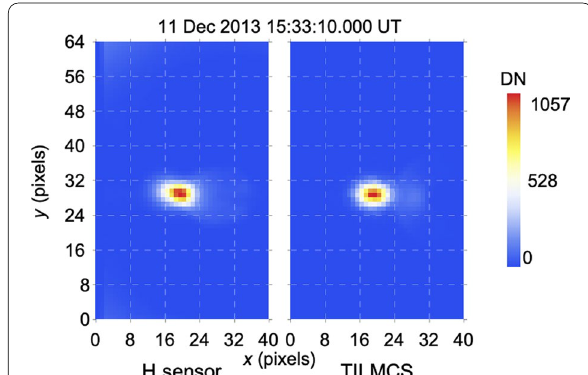
Fig. 5 Swarm C H sensor image (left) and TII MCS model (right): 11 December 2013 at 15:33:10 UT. Model parameters: 85% O + , 15% H + , T ix = 0.12 eV, T iy = 0.05 eV, v x = 7000 m/s, v y = 350 m/s, v z = 0 m/s, � S / C + V FP = − 1.47 V. The satellite was traveling southward at a latitude of about − 45 ◦